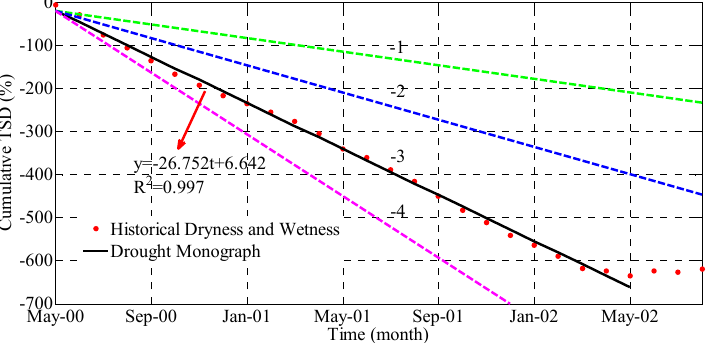
Figure 10. TSD (%) for the Liao River Basin during the period of 1985–2016.